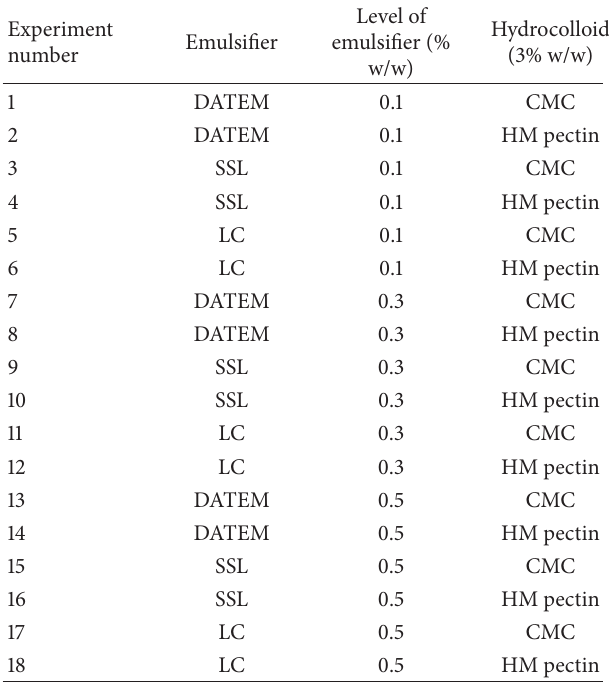
Table 1: Levels and types of emulsifiers and hydrocolloids added to composite cassava-maize-wheat (CMW) bread